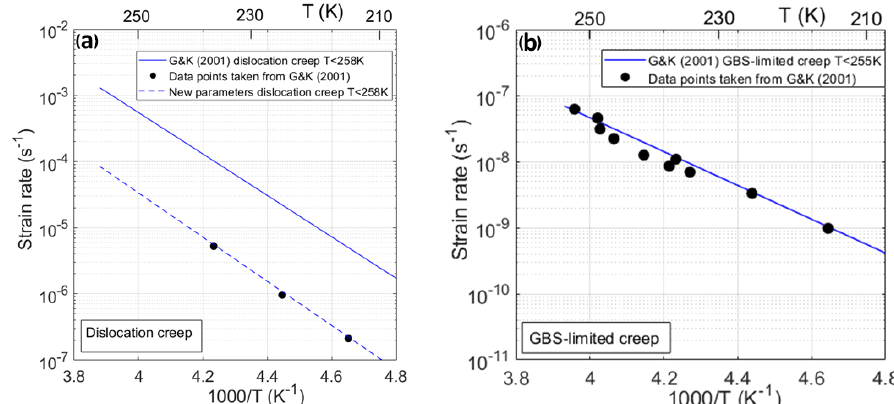
Figure 7. Arrhenius plot showing (a) the dislocation creep mechanism and (b) the GBS-limited creep mechanism below their temperature thresholds of 258 and 255K, respectively. A stress of 6.3MPa was used to calculate the strain rates in (a) and a stress of 0.53MPa and a uniform grain size of 73µm were used for (b) . The black dots are the experimental data points taken from Goldsby and Kohlstedt (2001). The solid lines represent the calculated strain rate using the original flow law parameters from Goldsby and Kohlstedt (2001) (Table 1). The dotted line, G&K mod , is the calculated strain rates for dislocation creep using the modified flow law parameters (Table 2).